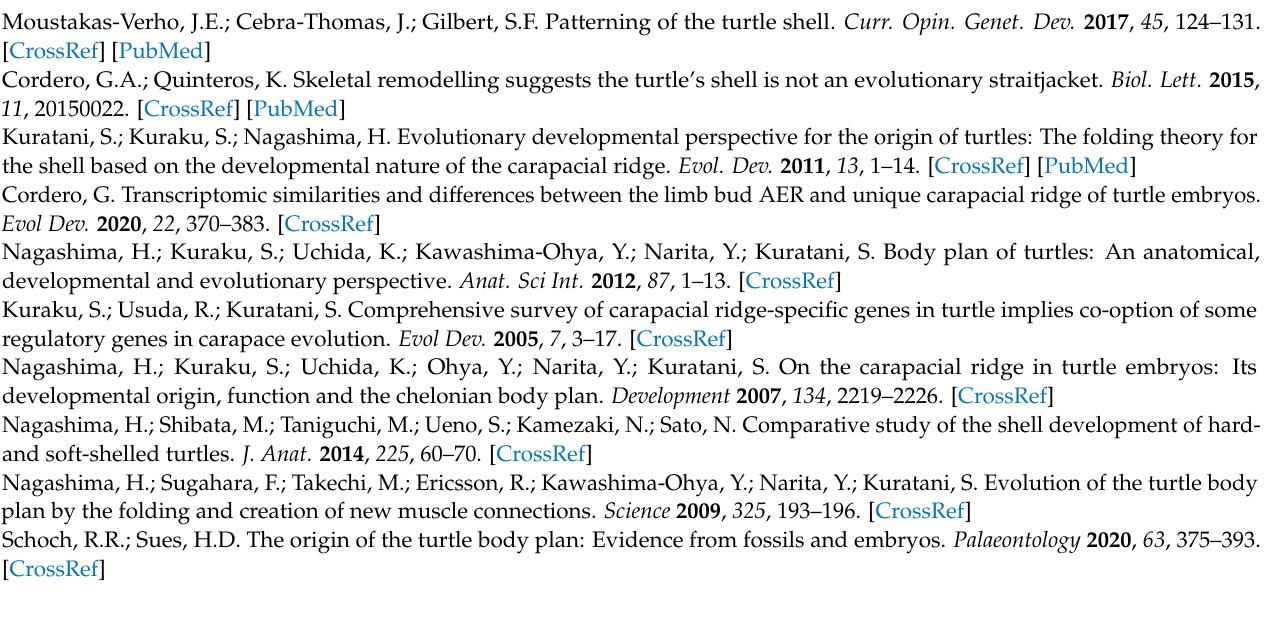
tary Information Table S8. Total target genes of Wnt signaling pathway. Supplementary Information Table S9. Weighted gene co-expression network analysis (WGCNA) of CR transcriptome of M. reevesii . Supplementary Information Table S10. Weighted gene co-expression network analysis (WGCNA) of CR transcriptome of P. sinensis